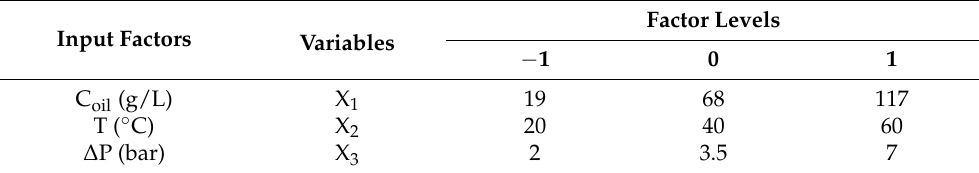
Table 2 summarizes the studied variables: initial oil concentration (X 1 ), temperature (X 2 ), and transmembrane pressure (X 3 ). Table 2. Variables and factor levels in the Box–Behnken experimental